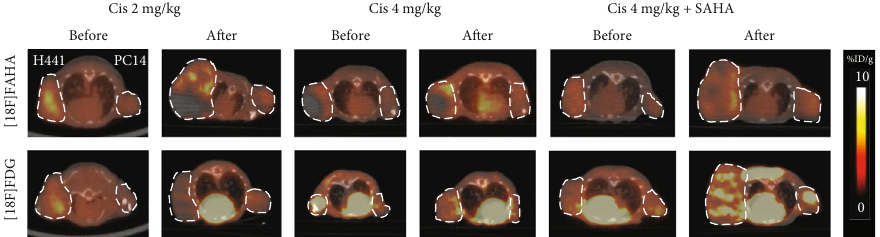
Figure 3: Axial tumor [ 18 F]FAHA (upper panel) and [ 18 F] FDG (lower panel) imaging before and after drug administration. [ 18 F]FAHA PET/CT images were summed over 10 min (20 – 30min after [ 18 F]FAHA injection). Cisplatin signi fi cantly increased [ 18 F]FAHA radioactivity in H441 and PC14 xenograft tumors, and this e ff ect was blocked by SAHA. [ 18 F] FDG imaging at 45 – 55min after injection. Tumor [ 18 F] FDG accumulation decreased after administration of cisplatin, but increased after administration of cisplatin with SAHA.